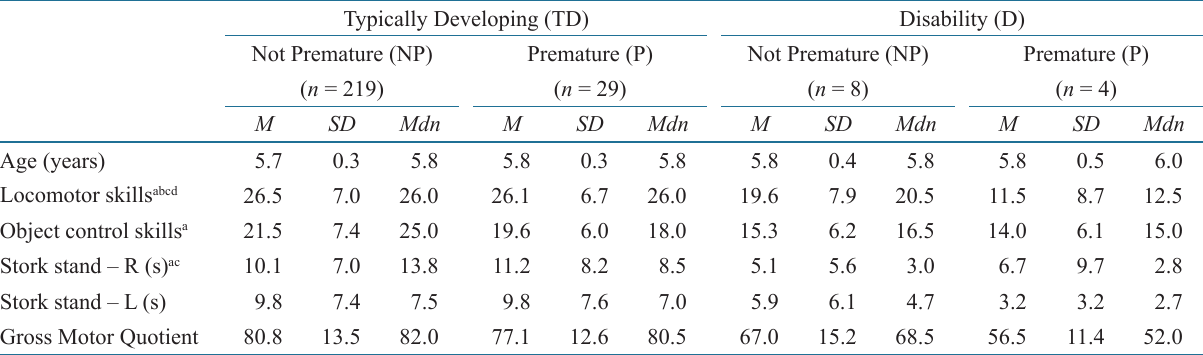
Motor skill performance of children in kindergarten by disability and prematurity status